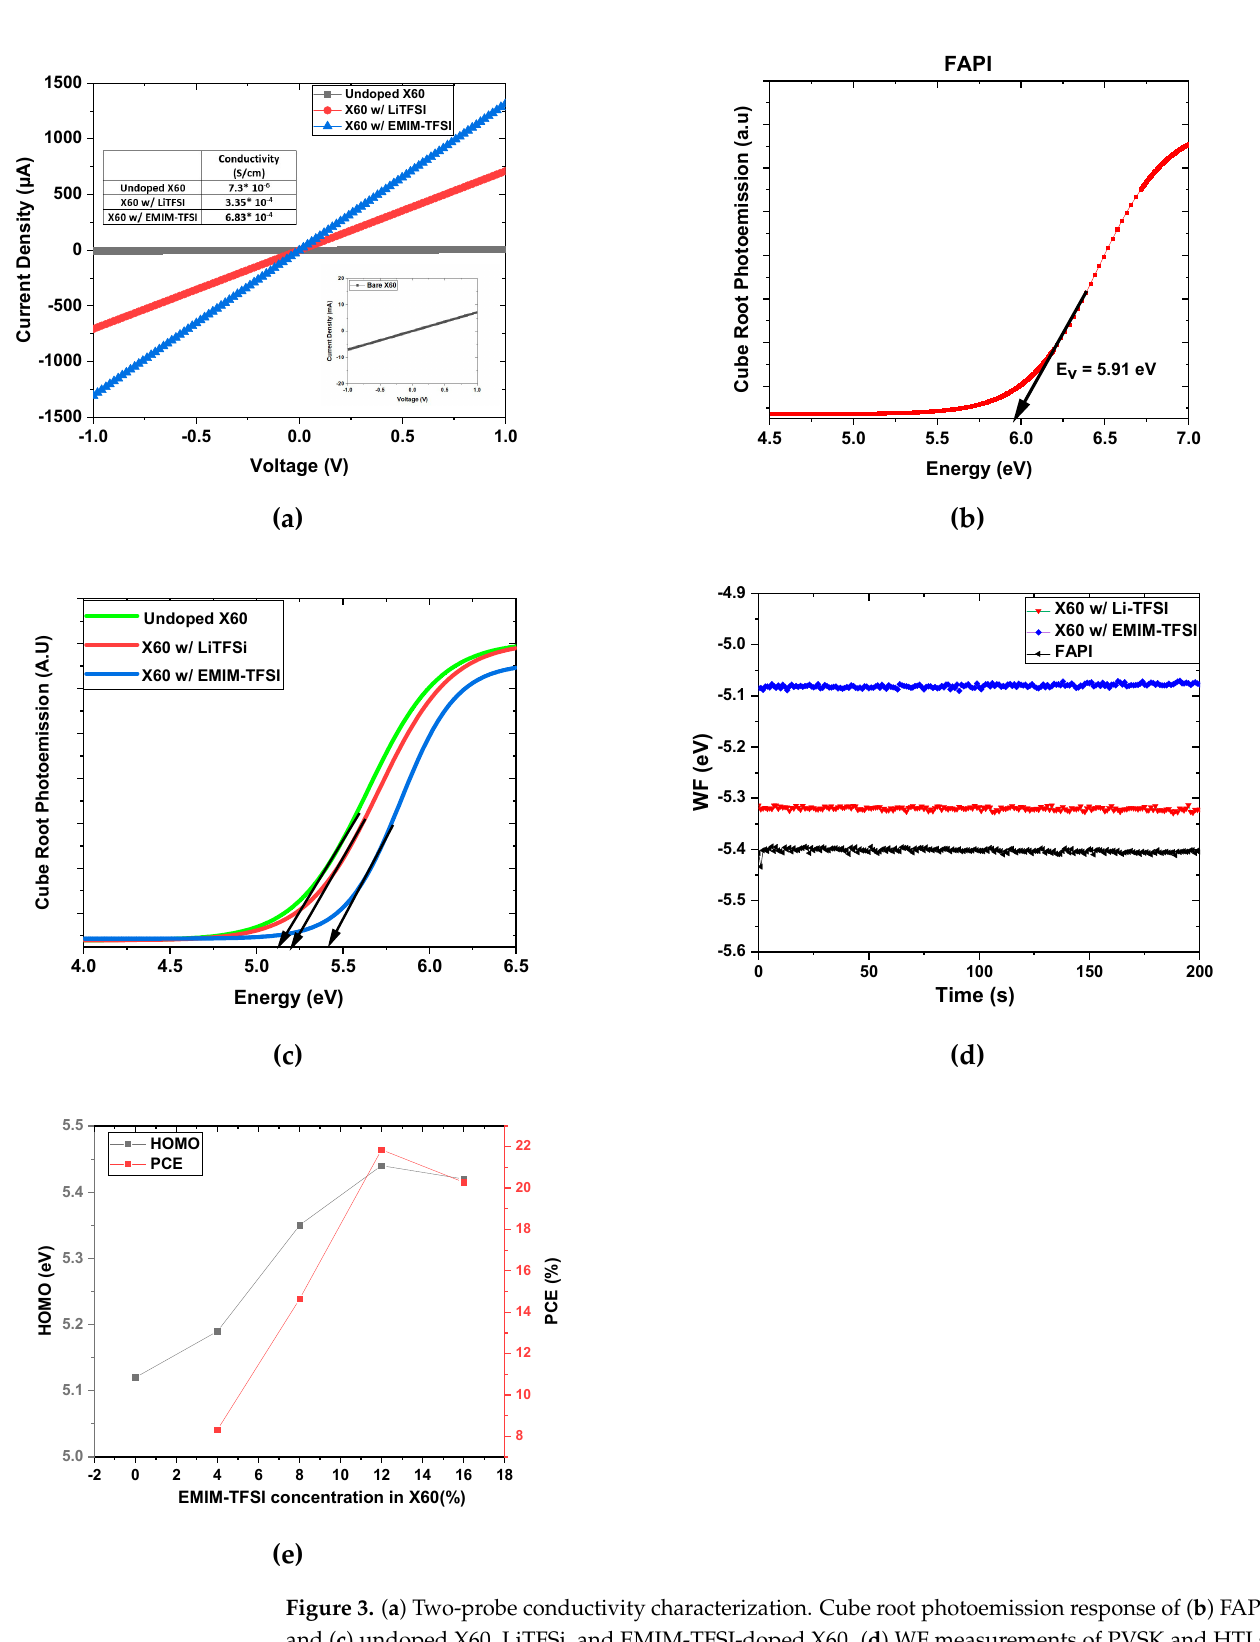
Figure 3. ( a ) Two-probe conductivity characterization. Cube root photoemission response of ( b ) FAPI and ( c ) undoped X60, LiTFSi, and EMIM-TFSI-doped X60. ( d ) WF measurements of PVSK and HTLs in the dark, and ( e ) the HOMO energy level position of X60 and the PCE as a function of EMIM-TFSI concentration.